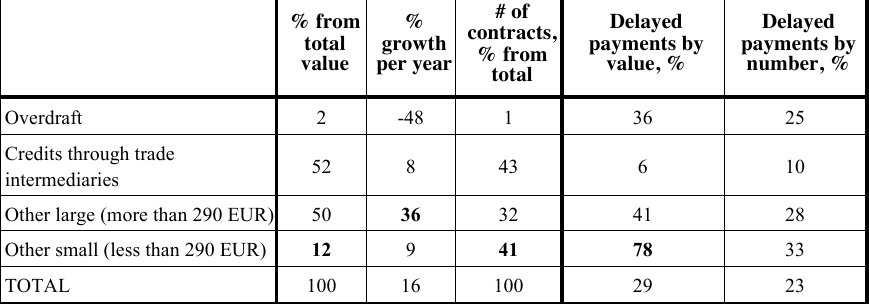
Table 8. Statistics on consumer credits provided and delayed in 2013, % by number and value (LB, 2014b)